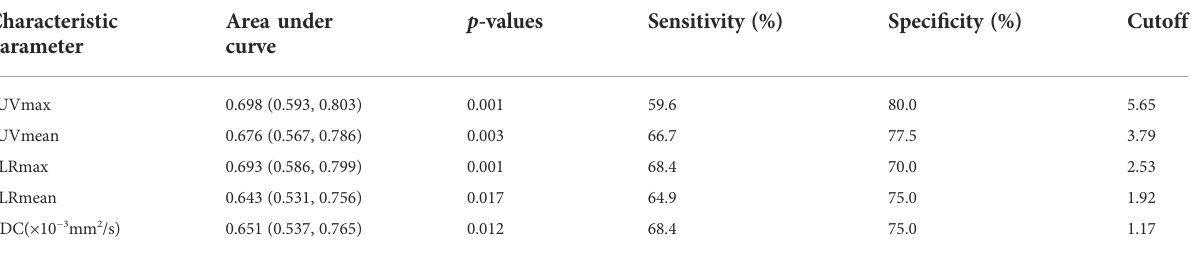
TABLE 3 ROC results of 18 F-FDG PET/CT parameters and ADC in predicting HCC with mVI in the pooled cohort. Characteristic